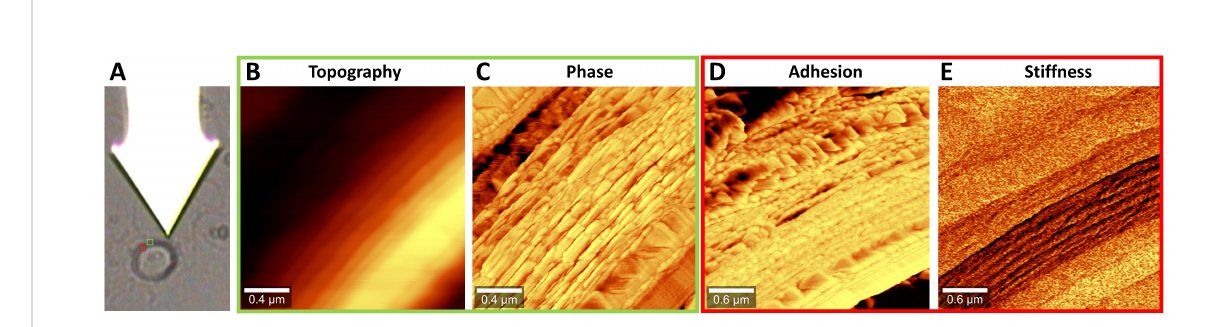
FIGURE 7 Atomic force microscopy of Spirogyra sp. zygospore walls. (A) Light microscopic image of the cantilever with the tip attached below and the zygospore cell wall with insets showing the scan areas (B, C) topography and phase image in intermittent contact mode, (D, E) adhesion and stiffness image in digital pulsed force mode